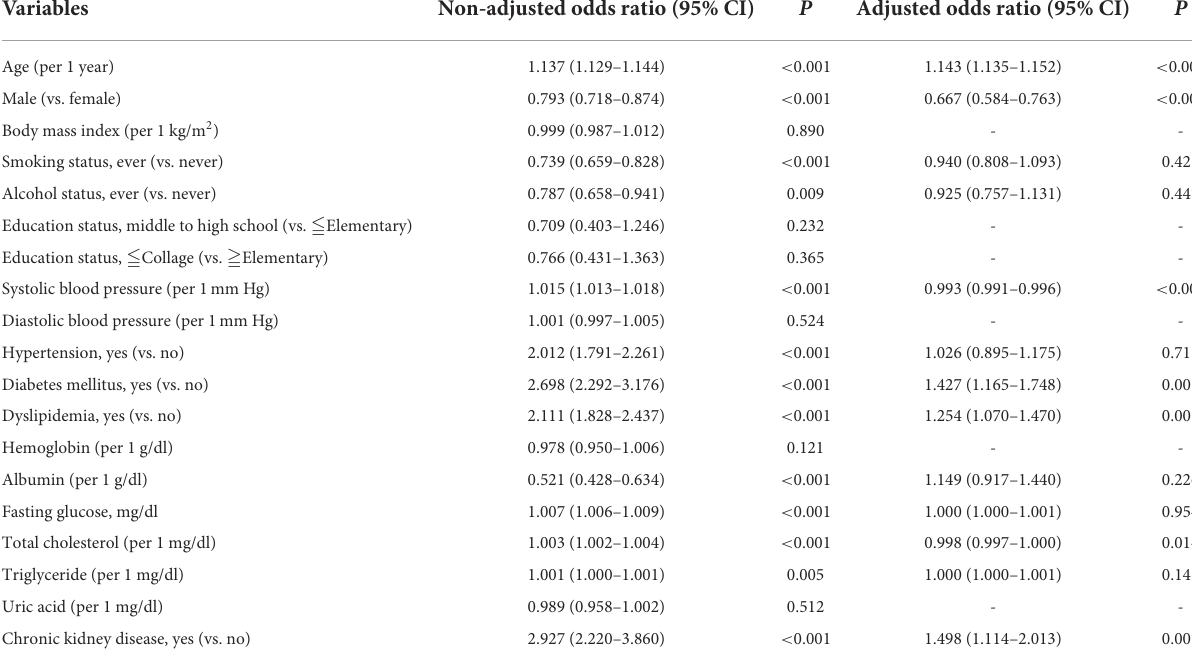
TABLE 4 Odds ratios for self-reported diagnosed cataracts in univariable and multivariable binary logistic analysis in the longitudinal cohort ( n = 24,569).